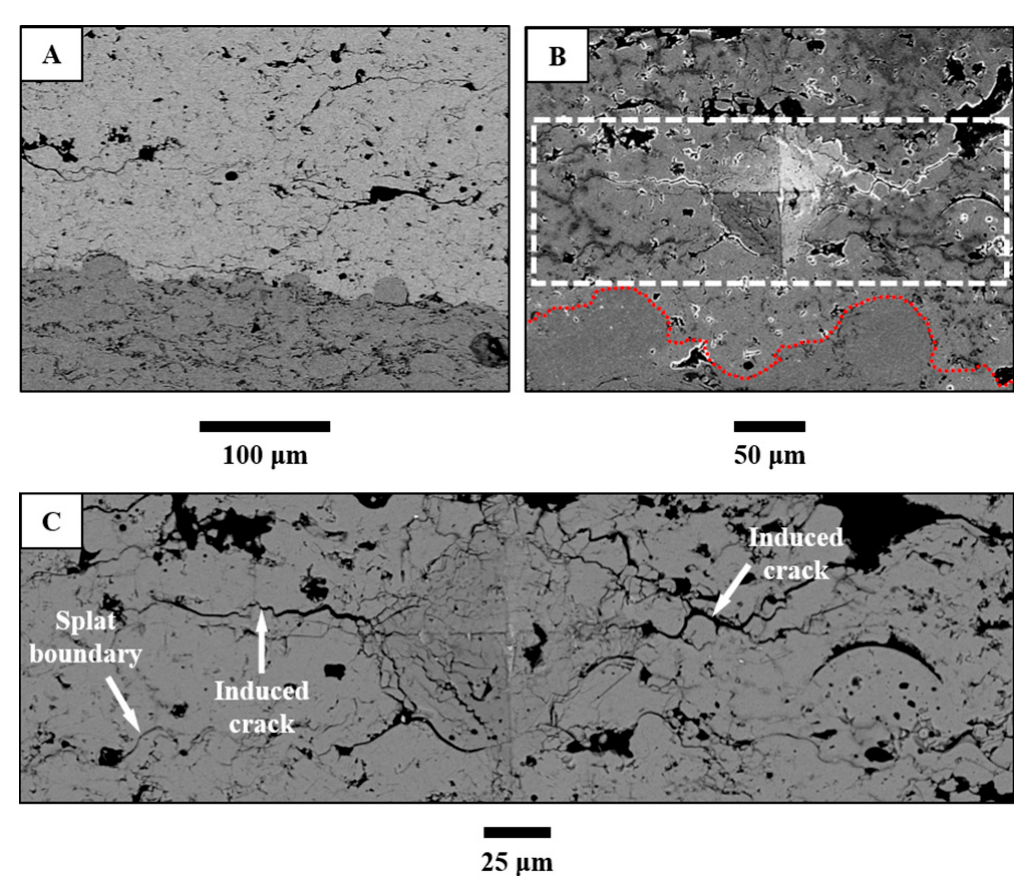
Figure 2. Cross-sectional images of TBCs with cracks induced by an indentation load of 30 N: ( A ) as-prepared image; ( B ) image of crack generation; and ( C ) highly-magnified image of the boxed area.